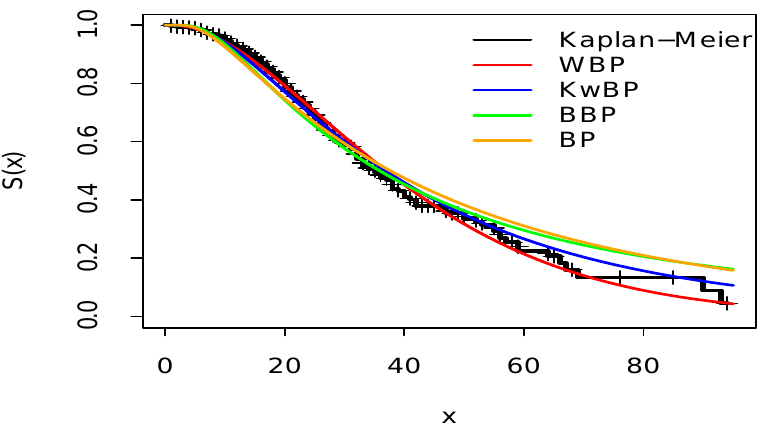
Figure 7. Empirical and estimated survival functions for COVID-19 data in Campinas.